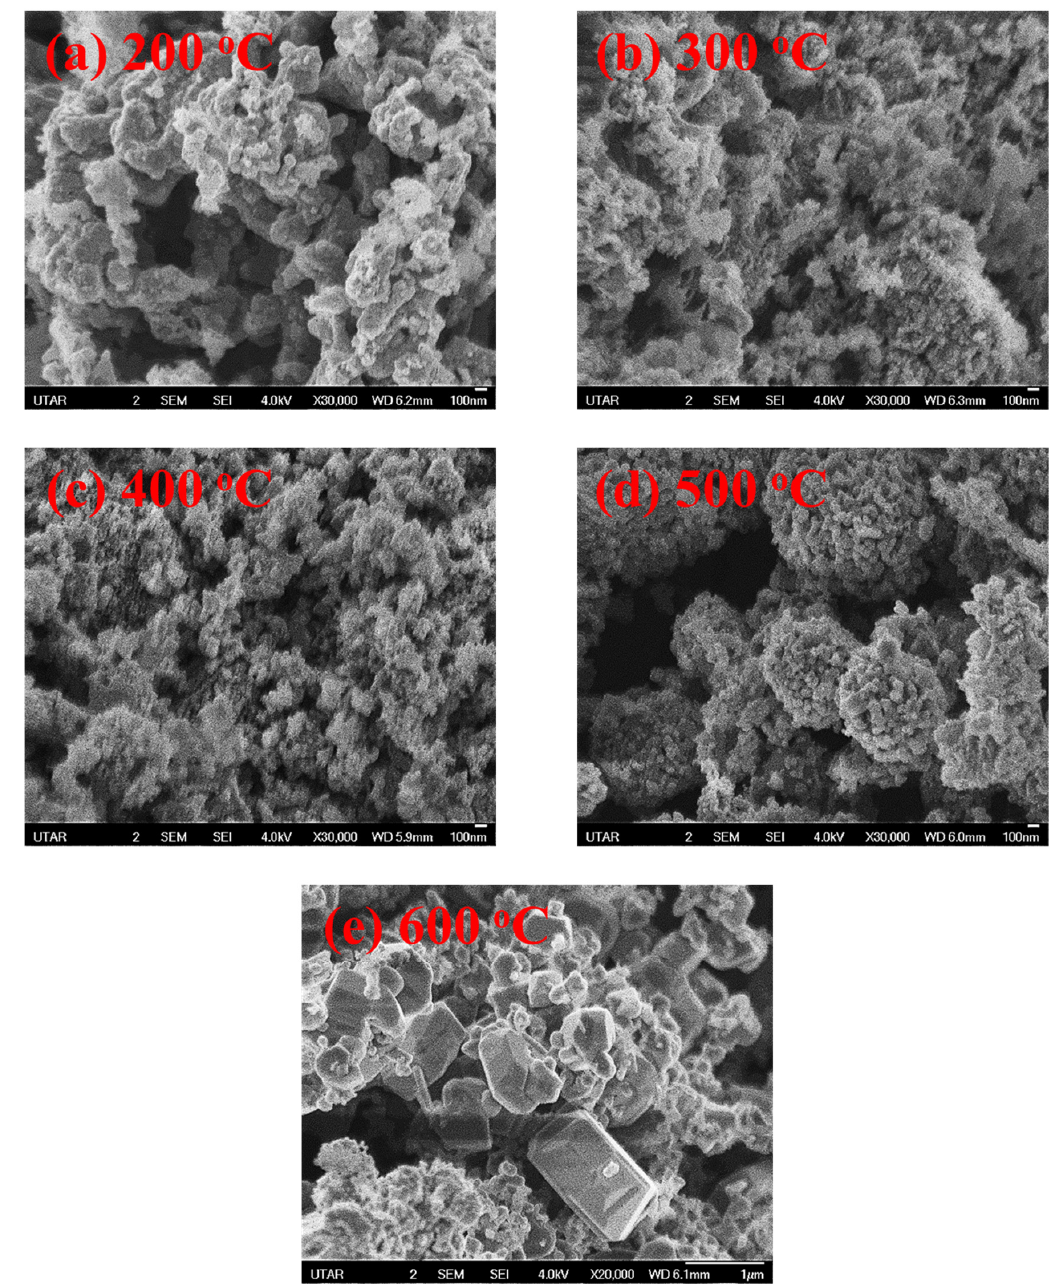
Figure 7. Morphologies of G. mangostana L. leaf extract-mediated synthesized CuO NPs calcinated at ( a ) 200 °C, ( b ) 300 °C, ( c ) 400 °C, ( d ) 500 °C and ( e ) 600 °C under SEM.